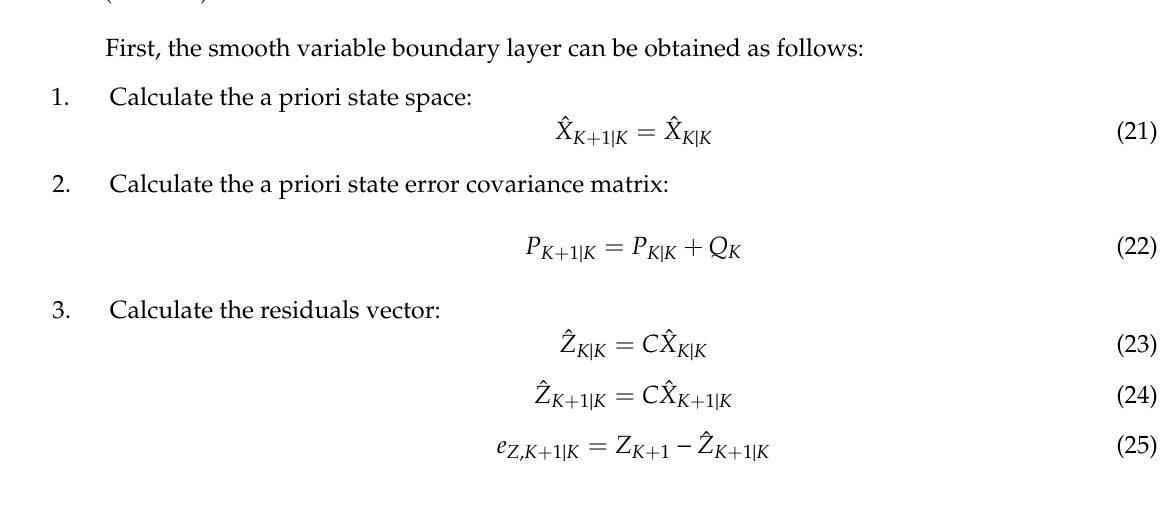
Figure 3. Concept of boundary layers of the Kalman filter–smooth variable structure filter (KF-SVSF) method.